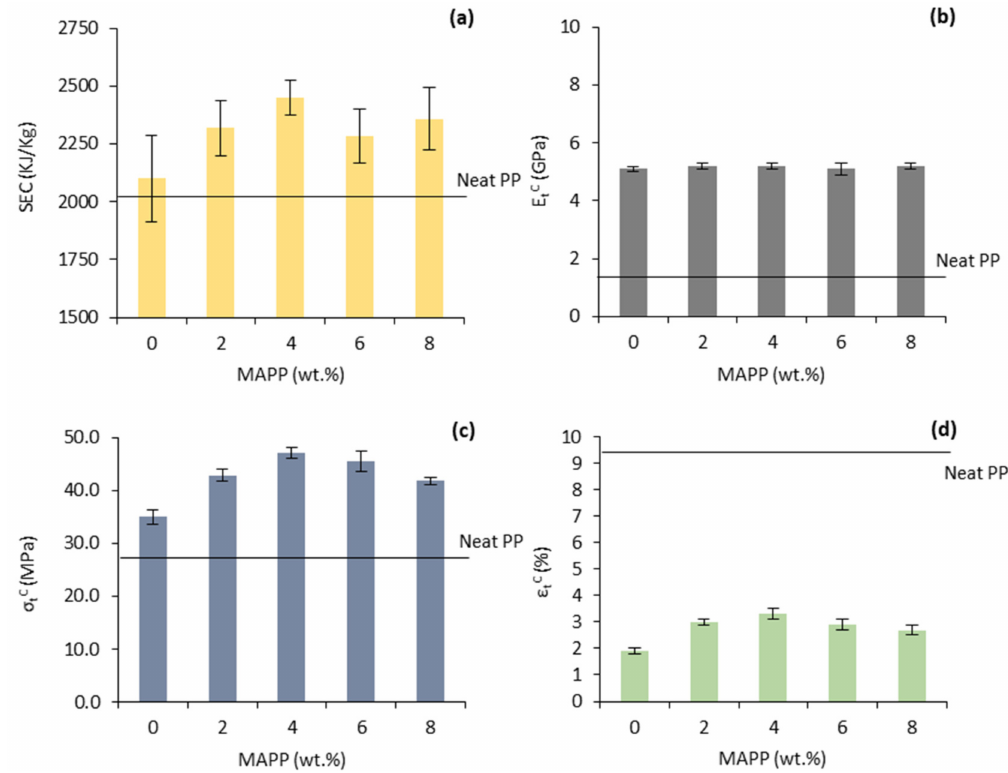
Figure 3. Effect of MAPP addition on the 40 wt.% henequen fibers-reinforced PP composites: ( a ) Specific energy consump- tion; ( b ) Young’s modulus (E t C ); ( c ) tensile strength ( σ t C ); ( d ) elongation at maximum stress ( ε t C